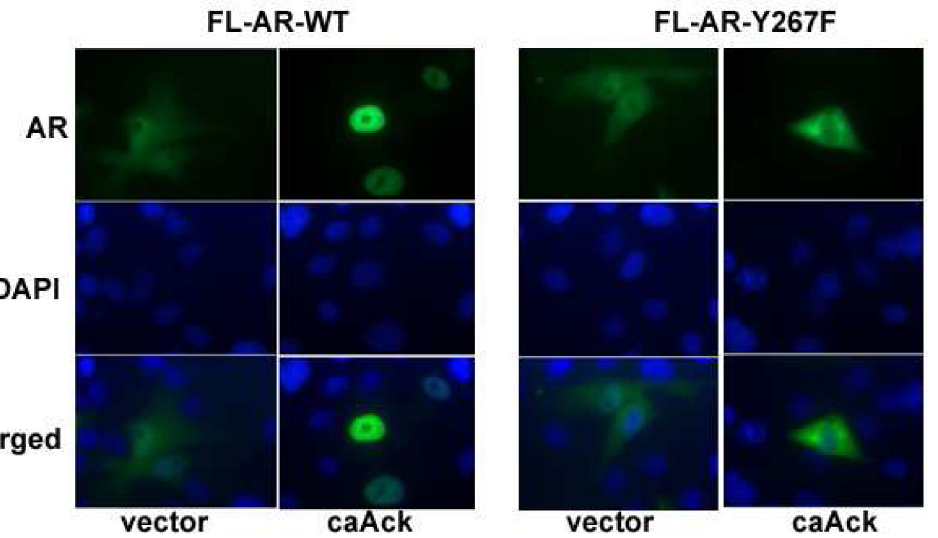
Fig 6. Nuclear translocation of AR induced by Ack1 kinase is defective in the AR Y267F mutant. COS-7 cells were transfected with the AR expression vector and the constitutively active Ack1 expression vector and incubated for 48 hrs. Cells were fixed and AR expression detected with the AR monoclonal antibody and FITC-conjugated secondary antibody. Nuclear staining was performed with DAPI. Original magnifications, 1,000X.